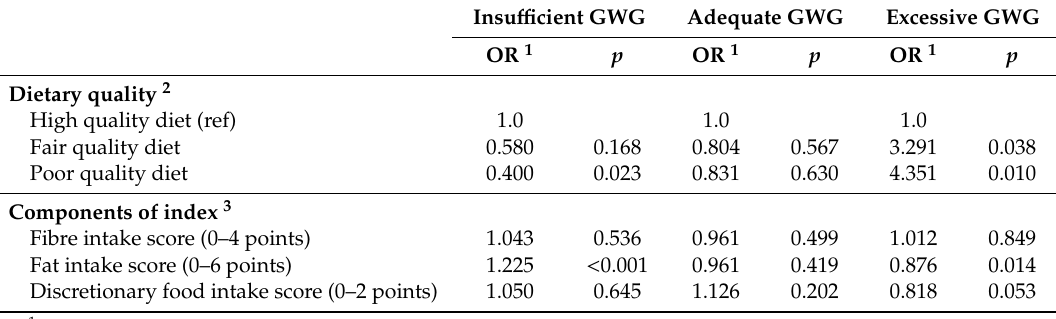
Table 5. Associations between mid-pregnancy dietary quality and adherence to the Institute of